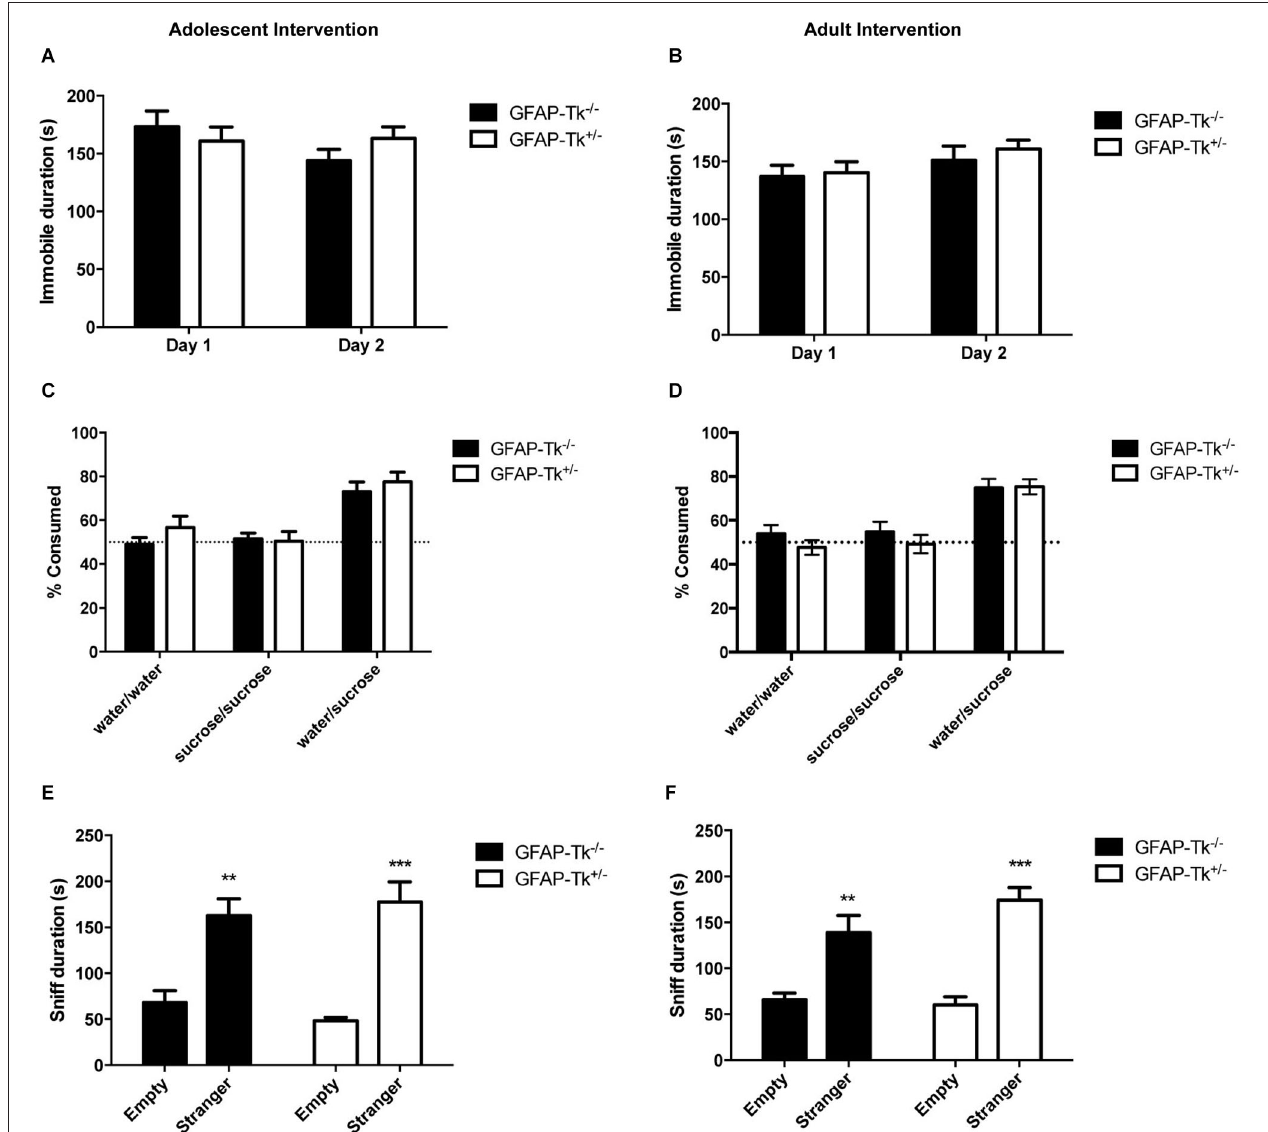
both the (E) adolescent and (F) adult groups displayed a preference to explore a stranger compared to an empty cup, ** p < 0.01, *** p < 0.001 stranger compared to empty cup. No difference between Tk − / − and Tk + / − was detected. Bars represent mean ± SEM. For FST and sucrose adolescent cohort GFAP-Tk − / − n = 25, GFAP-Tk + / − n = 27, adult cohort GFAP-Tk − / − n = 21, GFAP-Tk + / − n = 29. For social affiliation adolescent cohort GFAP-Tk − / − n = 8, GFAP-Tk + / − n = 12, for adult cohort GFAP-Tk − / − n = 6, GFAP-Tk + / − n =